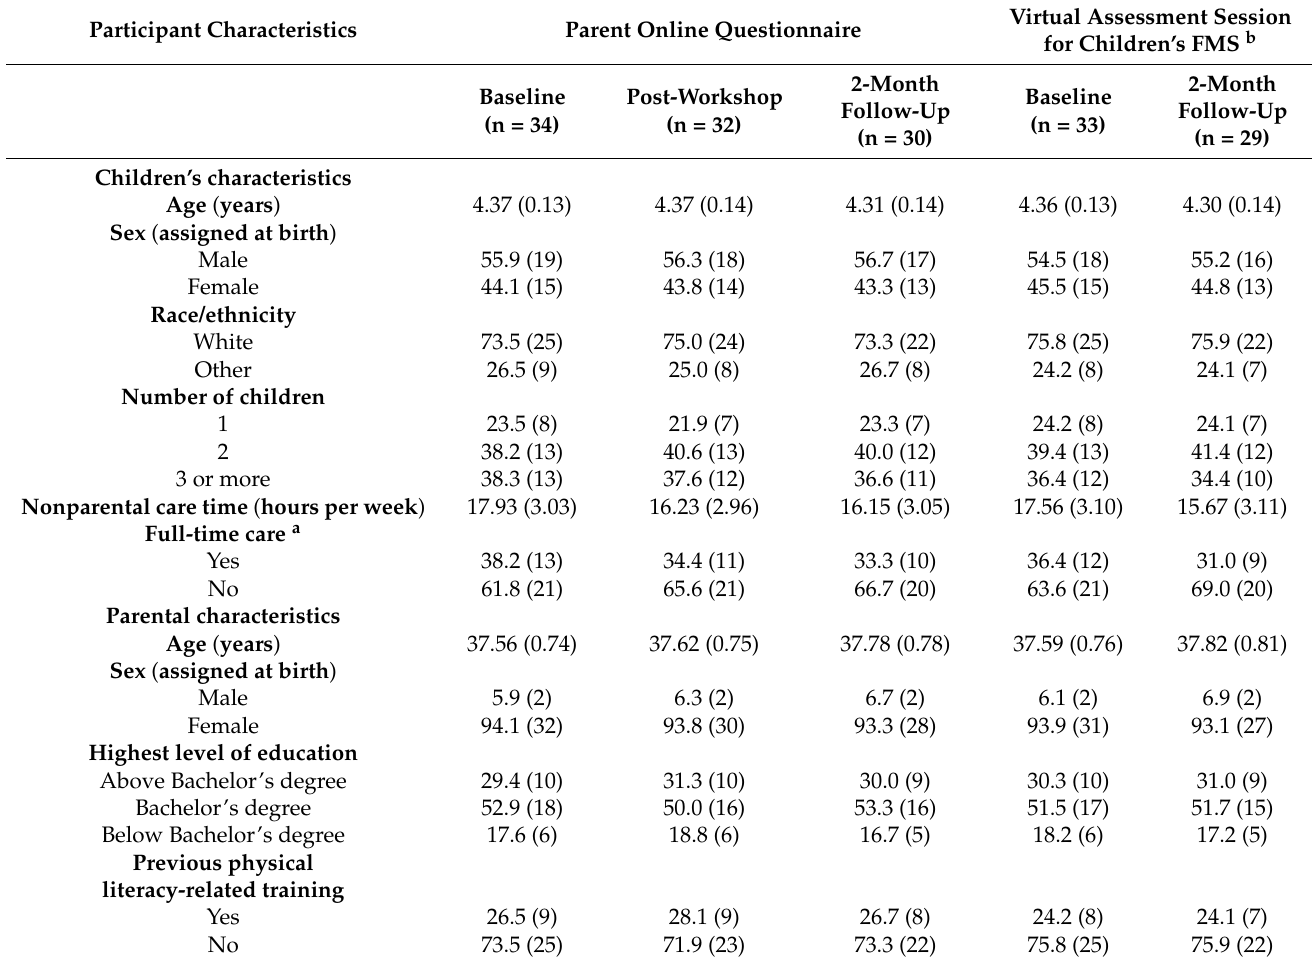
Table 1. Descriptive characteristics of participating children and